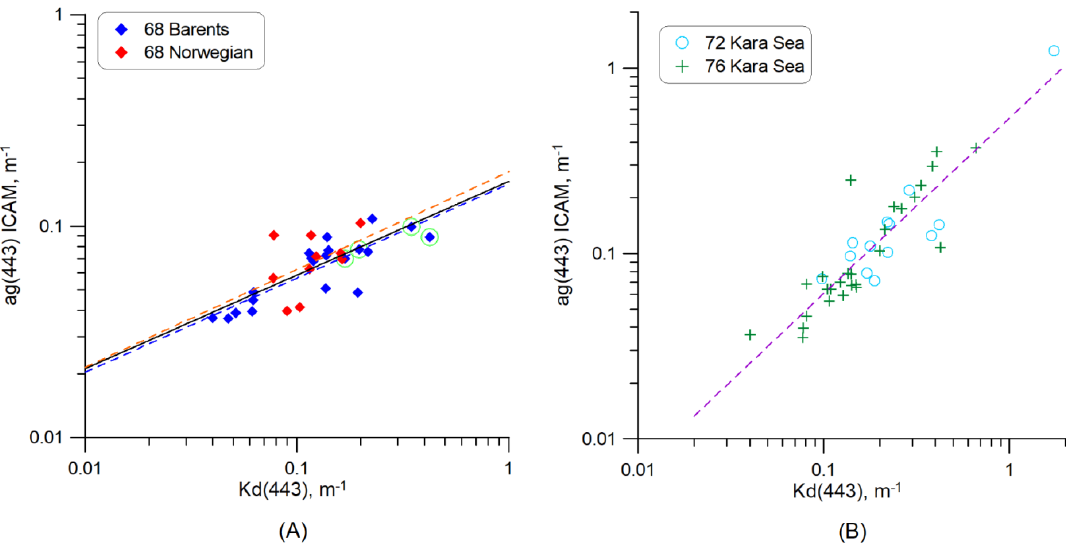
Figure 14. Comparison of the yellow substance absorption coefficient a g (443) and the diffuse attenuation coefficient K d (443) measured in situ: ( A ) for the Barents and Norwegian seas (AMK 68); ( B ) the Kara Sea (AMK 72 and 76). The solid black line is the regression line for all AMK 68 data; blue dotted line — the Barents Sea, AMK 68; red dotted line — the Norwegian Sea, AMK 68; purple dotted line — the Kara Sea, AMK 72 and 76. Green circles show the stations with coccolithophore blooms. Table 8. Regression parameters between values of a g and K d measured in situ at a wavelength of 443 nm. Regression Data Set N R 2 Data Set Equation